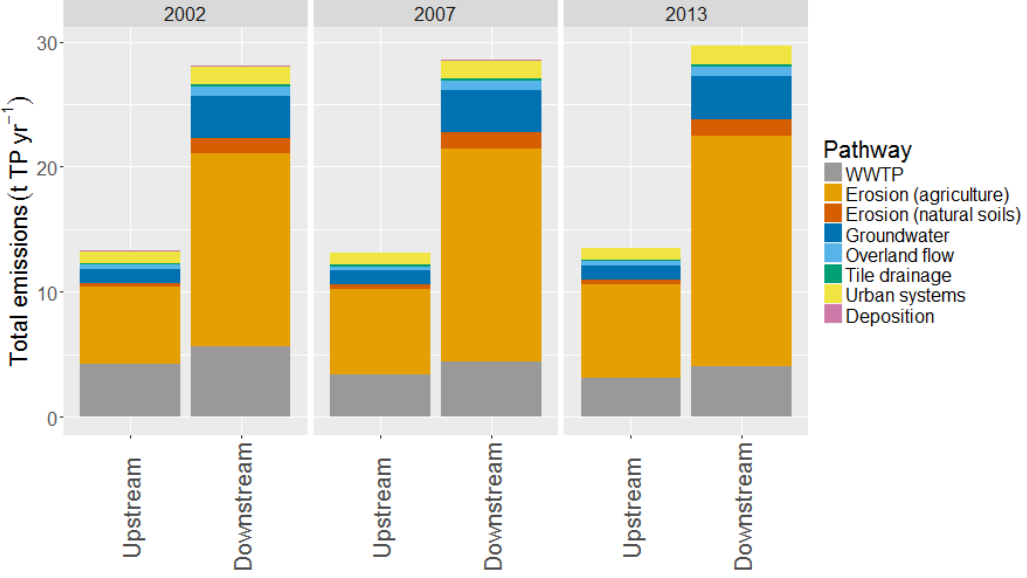
Figure 9. Total TP emissions and share of different pathways in the sub-catchments of the river Antiesen modelled with MONERIS for the years 2002, 2007 and